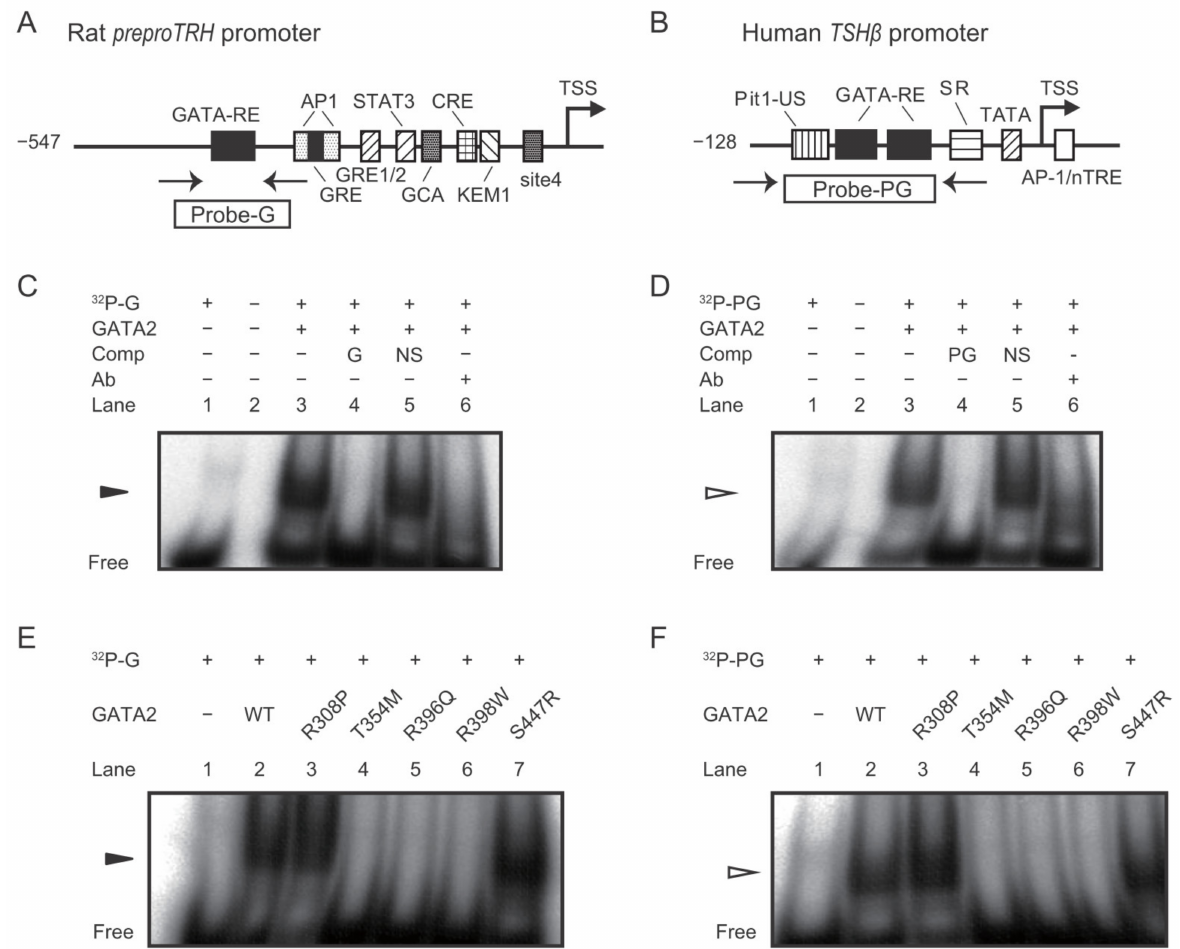
Figure 4. GATA2 mutations impair their DNA binding properties on rat preproTRH and human TSH β promoters. ( A , B ) Schematic representation of rat preproTRH and human TSH β promoter. The positions of primers for the oligo DNAs for gel shift assay are indicated. GATA-RE, GATA responsive element; AP-1, AP-1-binding site; GRE, glucocorti- coid responsive element; GRE1/2, glucocorticoid responsive element half-site; STAT, signal transducer and activator of transcription; CRE, cyclic AMP response element; GCA, GCA site; KEM1, KEM1 site; TSS, transcription start site; CAT, chloramphenicol acetyltransferase. Pit1-US; Pit1-binding site upstream of GATA-REs; SR, suppressor region; nTRE, negative T 3 responsive element. ( C , D ) Gel shift assays demonstrated single bands (arrows) when 32 P-labeled probe-G or probe-PG were incubated with nuclear extract of CV1 cells transfected with mouse GATA2 expression plasmid. The specific band signal (lane 3) was abolished by a 50-fold amount of cold probe-G or probe-PG (lane 4) but not nonspecific double strand oligo DNA (NS; lane 5). These signals were supershifted when GATA2 protein was mixed with the anti-GATA2 antibody (ab) before incubation with 32 P-labeled probes (lane 6). ( E , F ) Gel shift analysis with probe-G or probe-PG was conducted using nuclear extract of CV1 cells transfected with expression plasmids for various GATA2